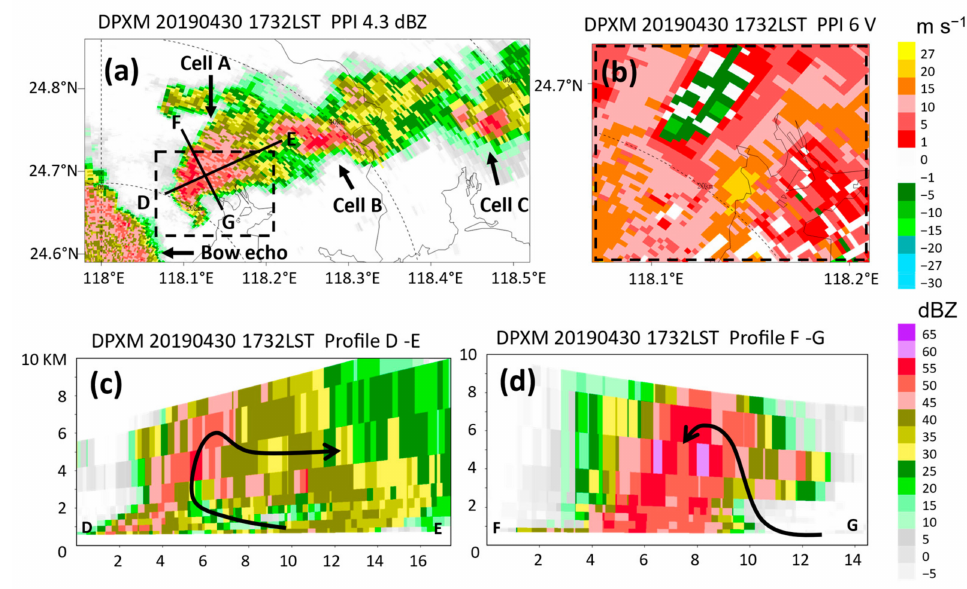
Figure 6. ( a ) Mini-supercell with a hook-shaped structure (shaded, 4.3 ◦ plan position indicator (PPI); unit: dBZ). ( b ) Mini-supercell with a velocity dipole (shaded, 6 ◦ PPI, and the direction of the positive Doppler radial velocity is northeast; unit: m s − 1 ) in PPI before merging with the bow echo. ( c ) Cross-section (shaded; unit: dBZ) along sections D–E in ( a ). ( d ) Transverse section (shaded; unit: dBZ) along sections F–G in ( a